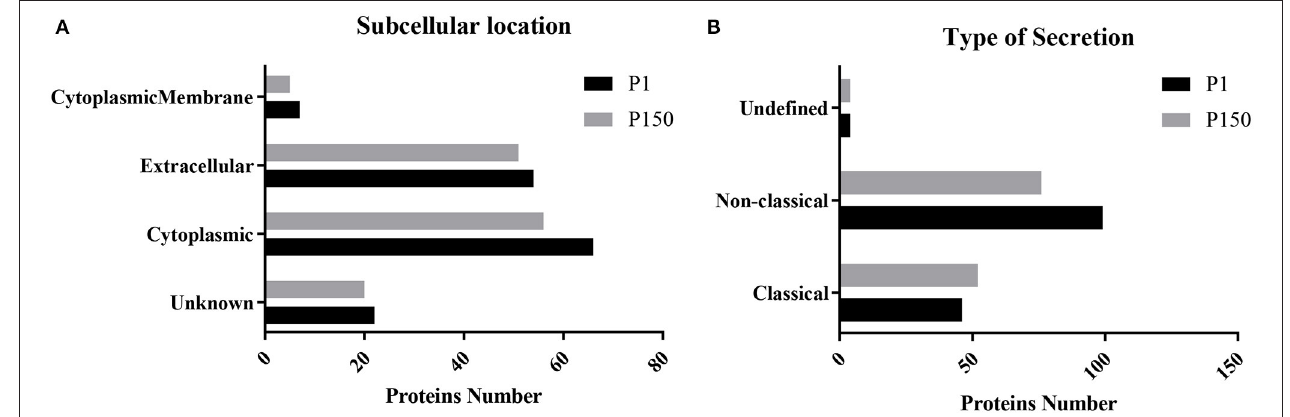
FIGURE 4 | Predicted secretion pathways and subcellular locations of Mycoplasma bovis proteins identified in the P1 (virulent) and P150 (attenuated) strains. (A) Type of secretion pathway. (B) Predictions of subcellular location.